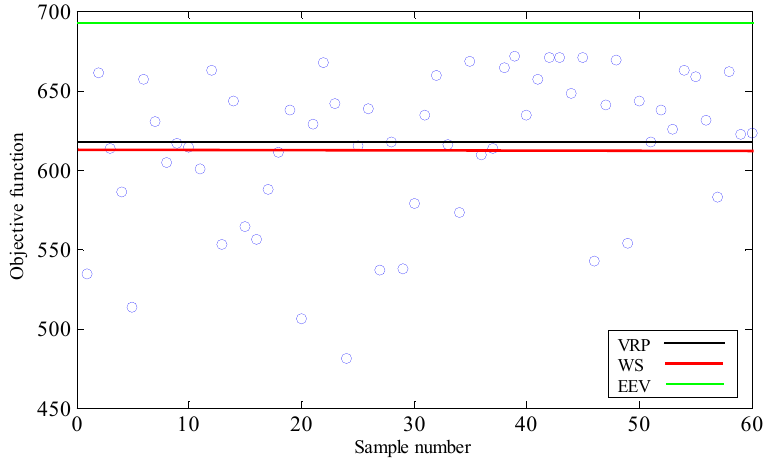
Figure 4. The values of distribution problem with WS and VRP.